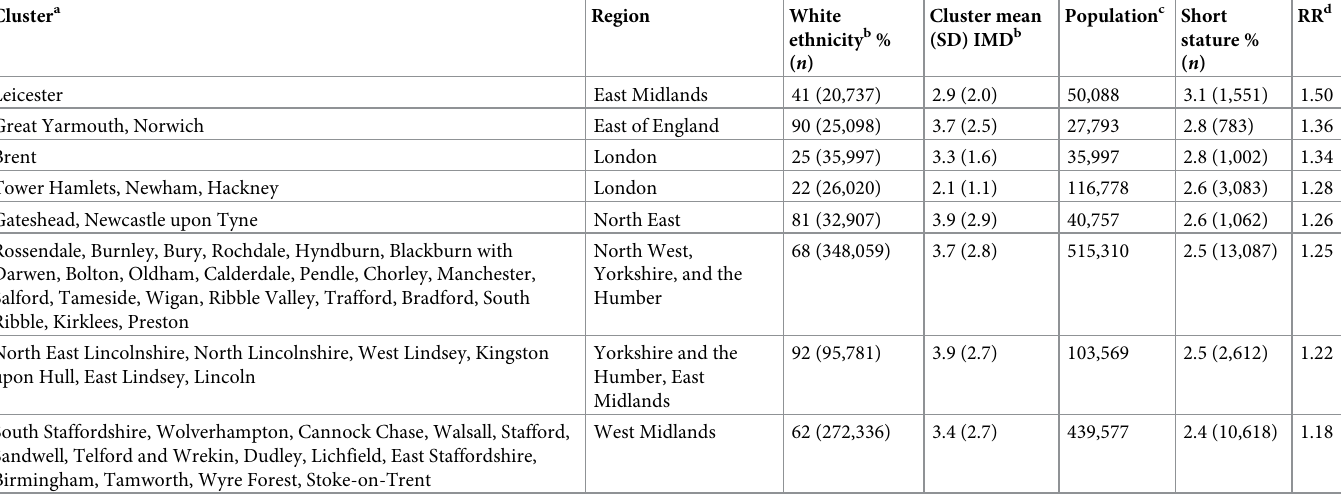
Table 2. Short stature clusters in England, 2006–2007 to 2018–2019, adjusted for ethnicity ( n =